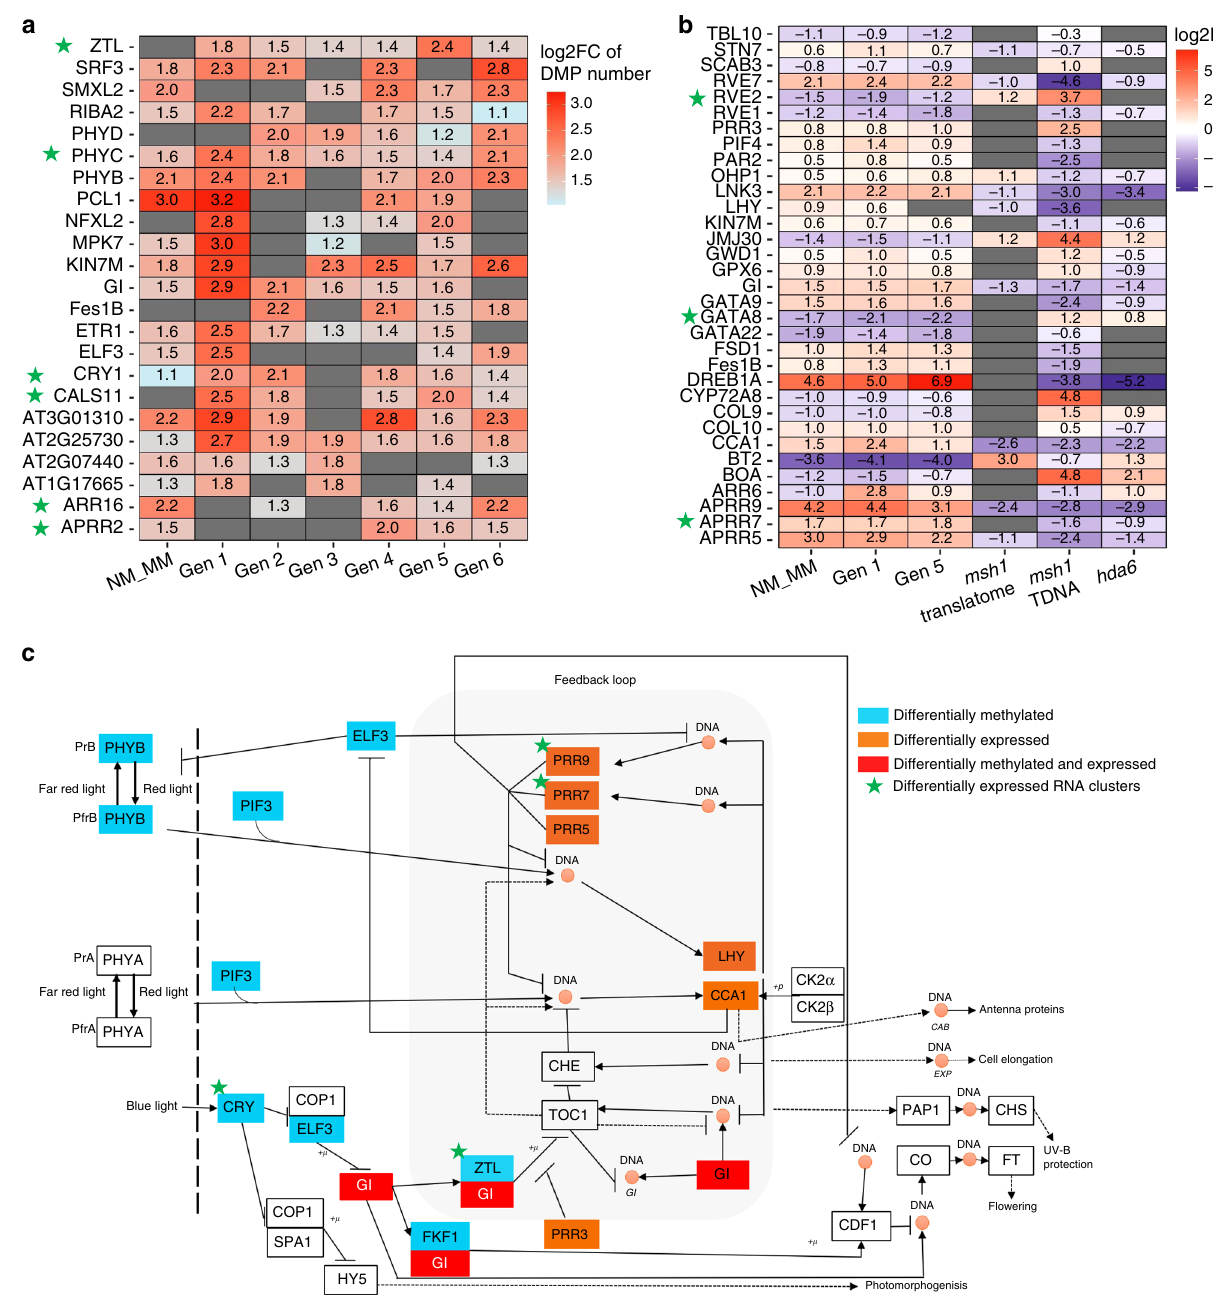
Fig. 6 Circadian rhythm network genes are both differentially expressed and methylated. a DMGs for the circadian rhythm (GO:0007623) network in msh1 memory line. Only genes identi fi ed as DMGs in at least four out of seven comparisons (Gen1 to Gen6 WT vs. MM and Gen1 NM vs. MM) are presented. Scale represents the log2 Fold change of DMP number at speci fi c genes in each comparison. b DEGs from the circadian rhythm (GO:0007623) network in msh1 memory line and msh1 mutant. Only genes identi fi ed as DEGs in at least four out of fi ve comparisons (Gen1 WT vs. MM, Gen1 NM vs. MM, Gen5 WT vs. MM, WT vs. msh1 translatome (TRAPseq) and WT vs. msh1 TDNA mutant) are presented. c DMGs and DEGs presented in panels ( a ) and ( b ) are positioned in the circadian clock network. The network is adopted from the KEGG database (Circadian rhythm — plant — Arabidopsis thaliana ). The hda6 transcriptome data were taken from Yu et al. 27 and reanalyzed using our pipeline. Genes associated with differentially expressed sRNA clusters were highlighted with a green star. Source data for generational DMGs are provided as a Source Data fi